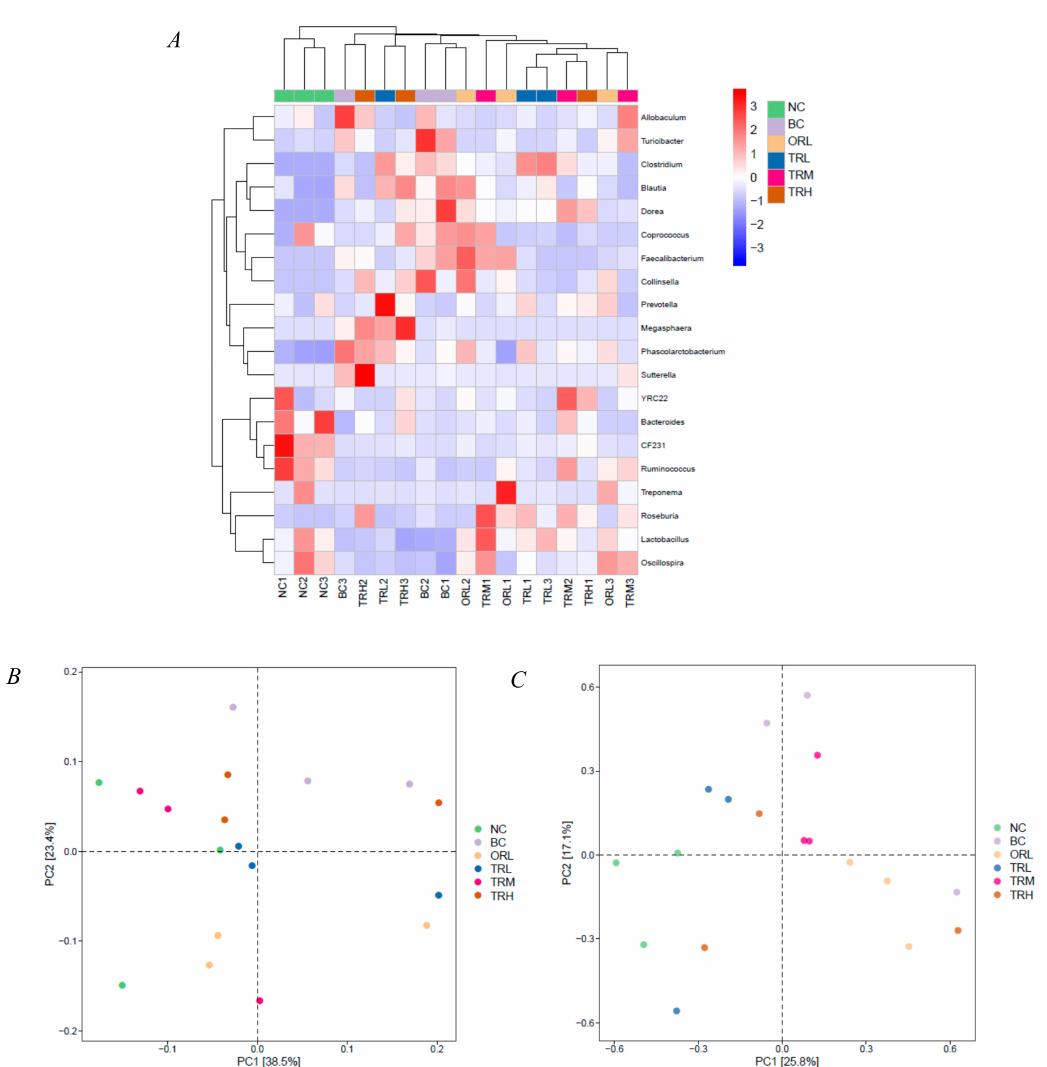
Figure 4. Heatplot ( A ), PCA ( B ), and OPLS-DA ( C ) analysis of the abundance of gut microbiota at genus level in the tested groups. NC: Normal control group, chow diet; BC: Blank control group, high-fat diet; ORL: Positive control group, orlistat; TRL: Low-dose group, trilobatin; TRM: Middle-dose group, trilobatin; TRH: High-dose group,